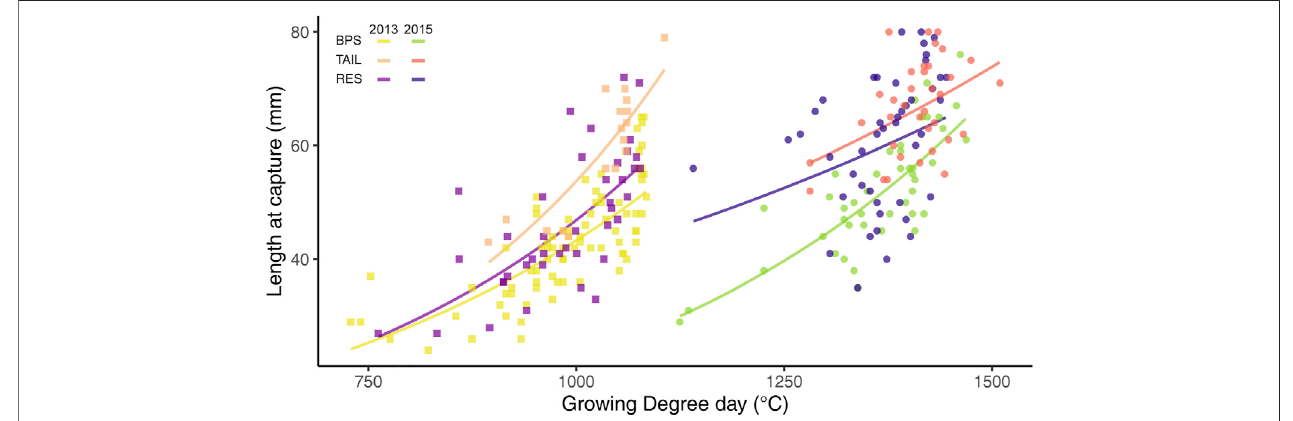
FIGURE 4 | Relationship between growing degree-days ( GDD > 12 ° C) and chub size at capture ( L cpt ), between years and sections. Curves are the estimated exponential regressions.